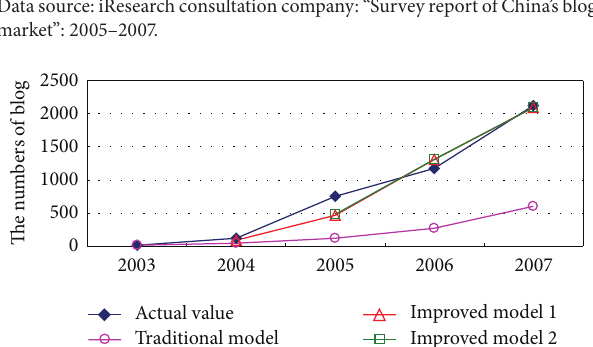
Figure 1: Curves of actual data, traditional grey Verhulst model, and grey time-delayed models ( 𝜏 0 = 1 and 𝜏 0 = 2 ,